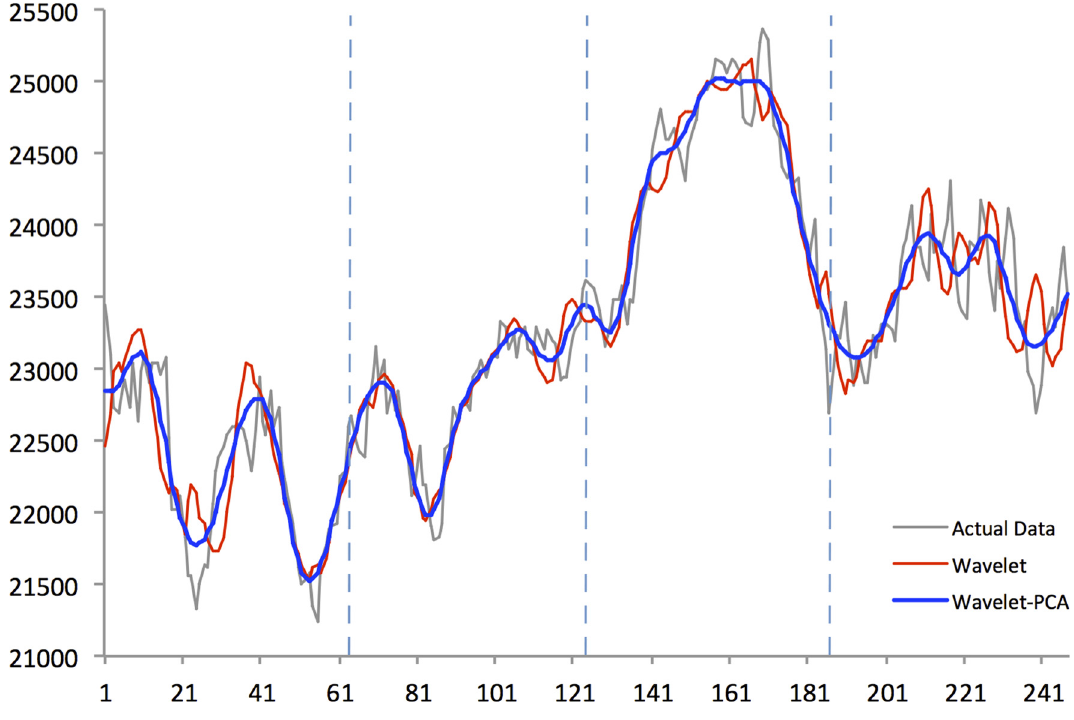
Fig 4. Univariate (Wavelet) and Multivariate (Wavelet-PCA) Denoising of Hang Seng futures